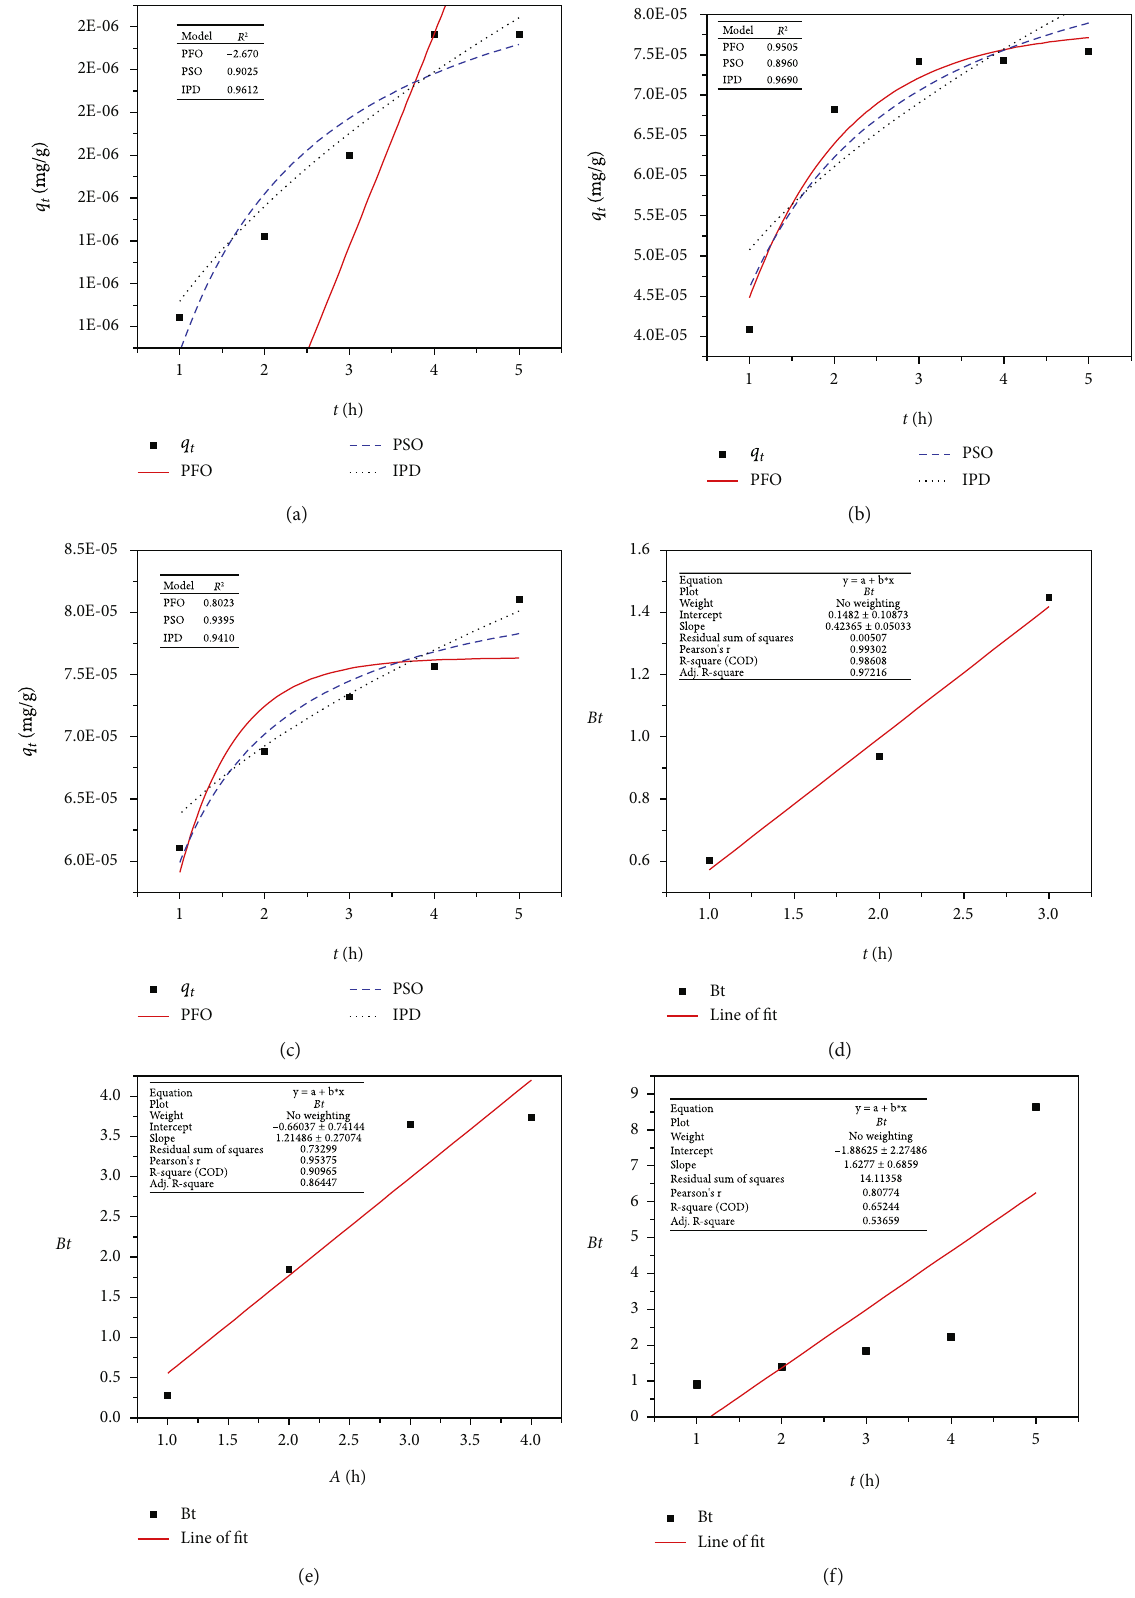
Figure 6: Kinetic model description for adsorbents: (a) control, (b) PB, (c) PBNP, (d) plot of the Boyd kinetic model for control adsorbent, (e) plot of the Boyd kinetic model for PB adsorbent, and (f) plot of the Boyd kinetic model for control